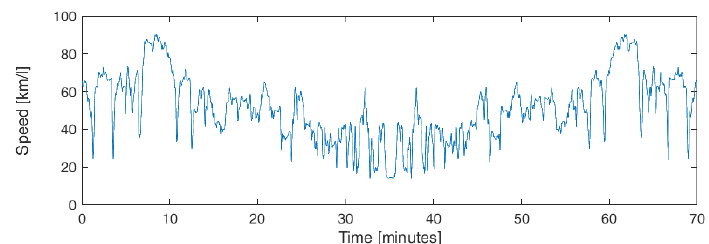
Figure 20. Speed profile, mountain mission 2.